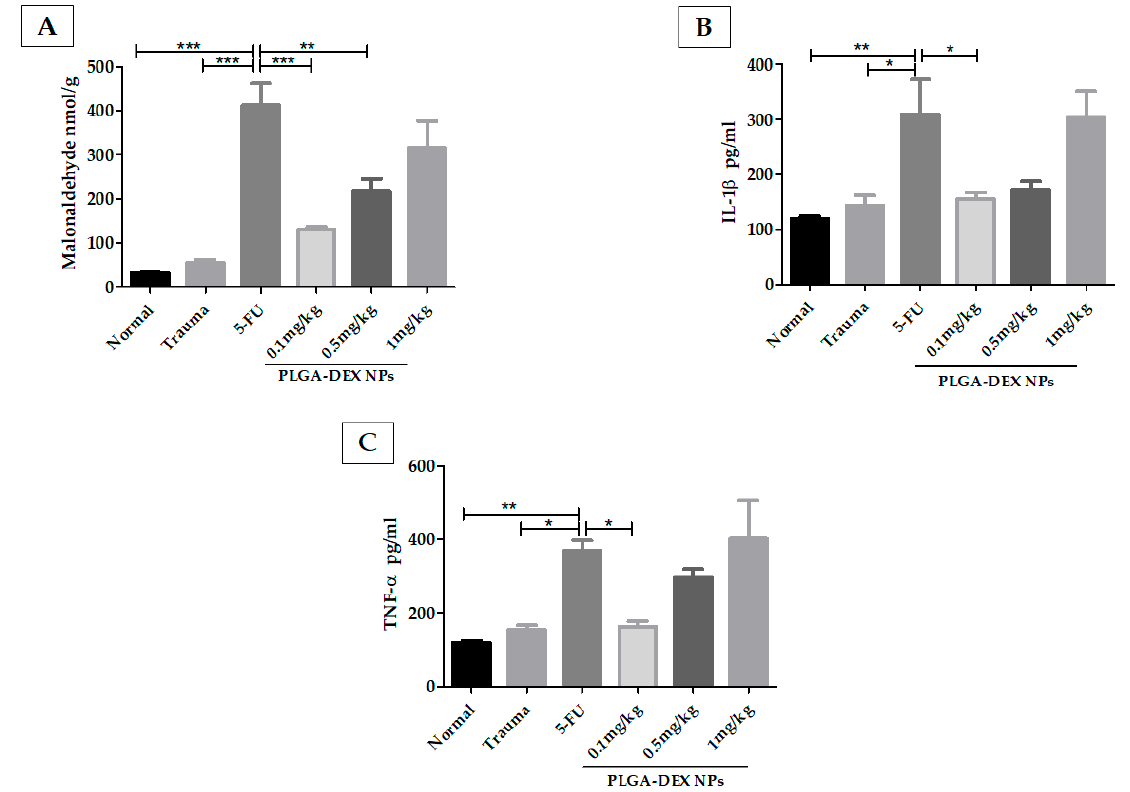
Figure 4. Malonaldehyde (MDA) and cytokine quantifications in the hamster oral mucosa to evaluate the therapeutic outcome of PLGA-DEX NPs in OM induced by 5-FU. ( A ) MDA. ( B ) IL-1 β . ( C ) TNF- α . Normal group: animals with healthy oral mucosa. Trauma group: animals subjected only to excoriations in the oral mucosa, but they do not present OM. Group 5-FU: animals with untreated OM only received purified water, i.p. The PLGA-DEX NPs groups (0.1; 0.5 or 1 mg/kg) received 5-FU and were subjected to MT with consequent OM induction, which was treated with PLGA-DEX NP i.p. in the dose corresponding to the group to which they belonged. The results are presented as the mean ± standard error ( n = 5). * p < 0.05, ** p < 0.01, *** p < 0.001 (ANOVA with Tukey’s posttest).